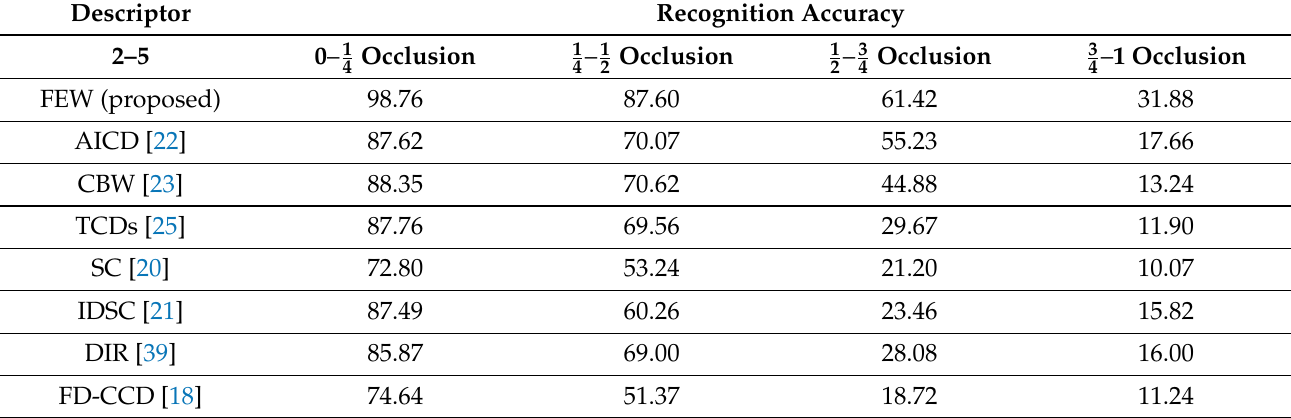
Table 6. Comparison of different degrees of